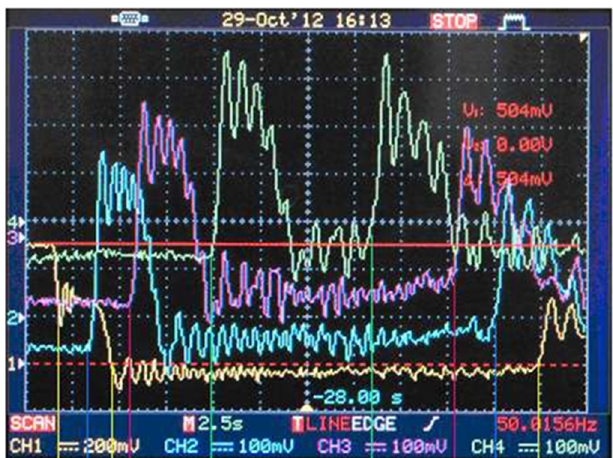
Figure A1. A typical oscillogram of tsunami-type wave registration in a hydrodynamic channel. Label 1 shows the initial position of the measuring channel of sensor No.1 (yellow), which measures the water level in the wave generator. An increase in the water level in the generator before wave generation by η 0 = 0.02 m corresponds to an upward shift of the beam by 491.4 mV. The sensor registered a sharp drop in the water level by − 240 mV after the start of the wave generator. This level drop corresponds to a wave that propagates inside the generator and has a height of A = − η 0 /2 with a measurement error of δ = 2.32%. Sensors No. 2–4 (blue and cyan) register waves in the working part of the wave tray. The distance between sensors No.2 and No.4 is 6.7 m. It can be seen from the 546 oscillogram that the time it takes the wave to cover this distance is ∆ t = 6.56 s. Thus, the experimentally measured wave speed is c = 1.03 m/s. The group velocity of such a single wave calculated on the basis of the linear theory of shallow water is c = (cid:3493)(cid:1859)(cid:1834) = 1.001 m/s . From Figure it can be seen that the wave that propagates into the working channel of the flume has a time extension of about T ≈ 3 s, thus: L = 2 a = cT ≈ 3